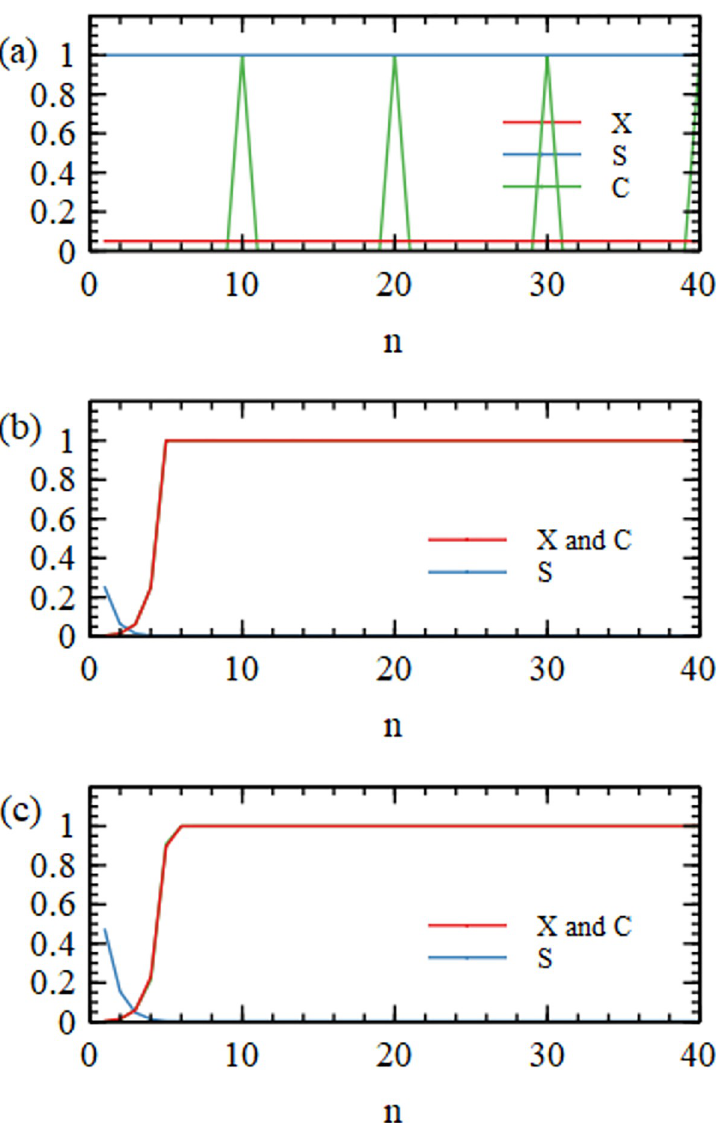
Fig 7. Connectivity X, Specificiy S, and Circularity C functions for (a) perfect virtual circle mixture, (b) complete random mixture with all words present, (c) simulation run 500Y1.